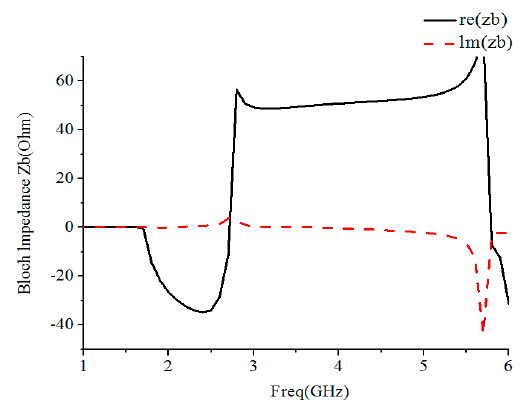
Figure 5. Extracted Bloch impendence of the unit cell with C L,var =1.3 pF.